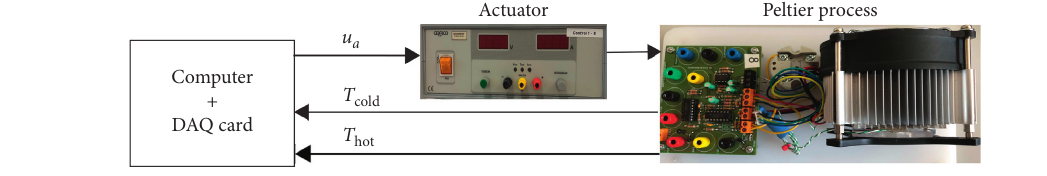
Figure 19: The real process based on a Peltier cell.